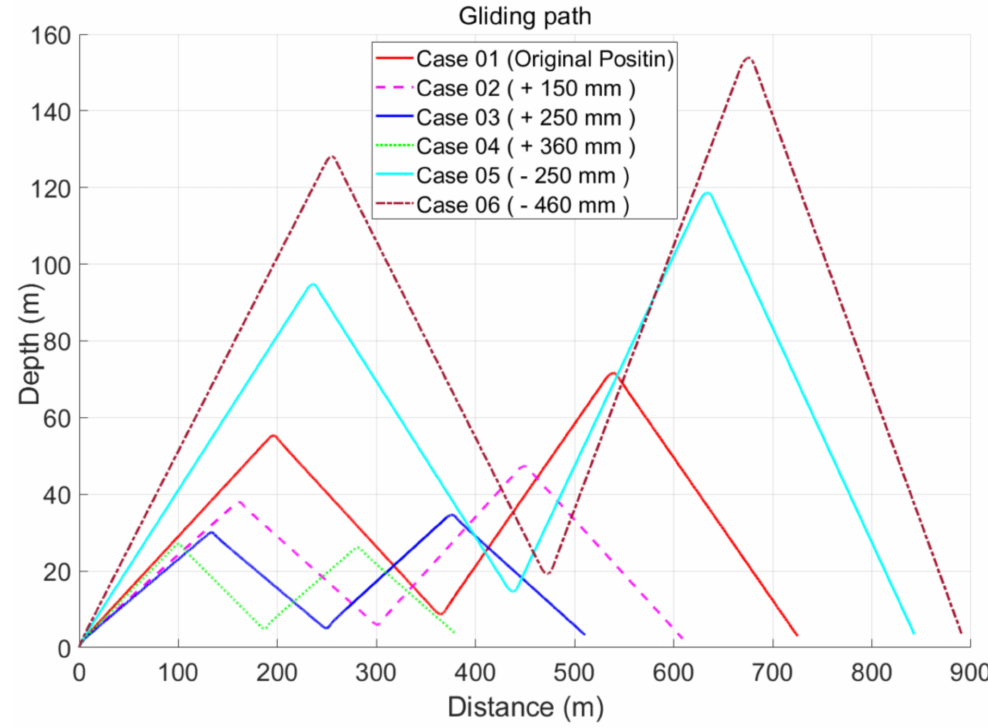
Figure 15. Simulation results of the gliding path.